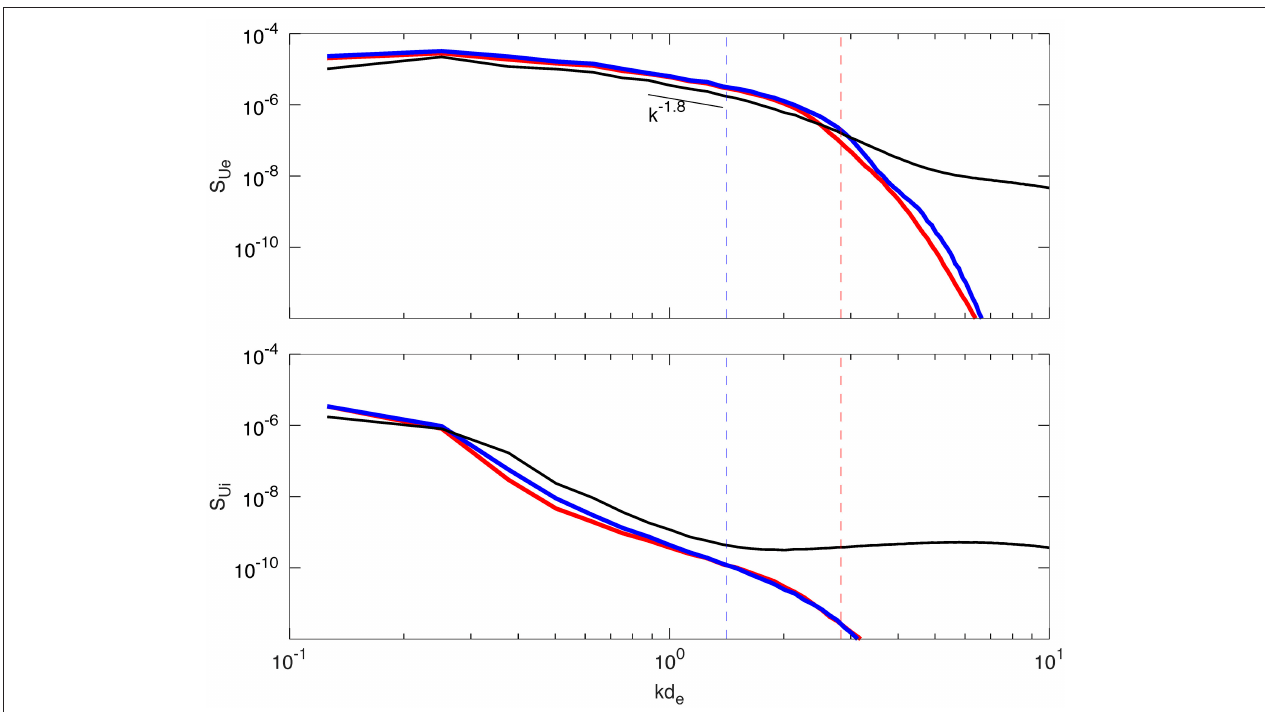
FIGURE 6 | Spectra of electron (Top) and ion (Bottom) velocity fluctuations t (cid:127) ci panels, the blue and red curves correspond to SPS simulations with N h out due to effects of numerical